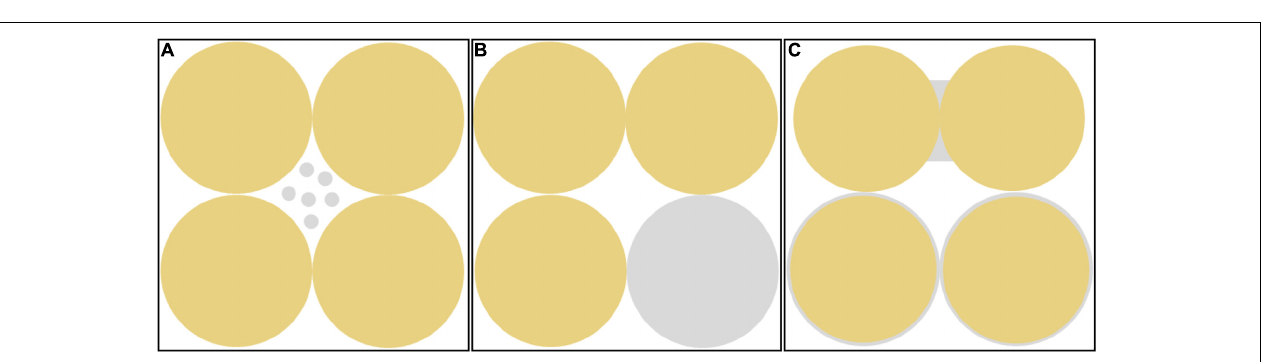
FIGURE 1 | Microstructure in gas hydrate-bearing sediments. The white, orange, and blue colors indicate the hydrate, grain, and pore fluid.